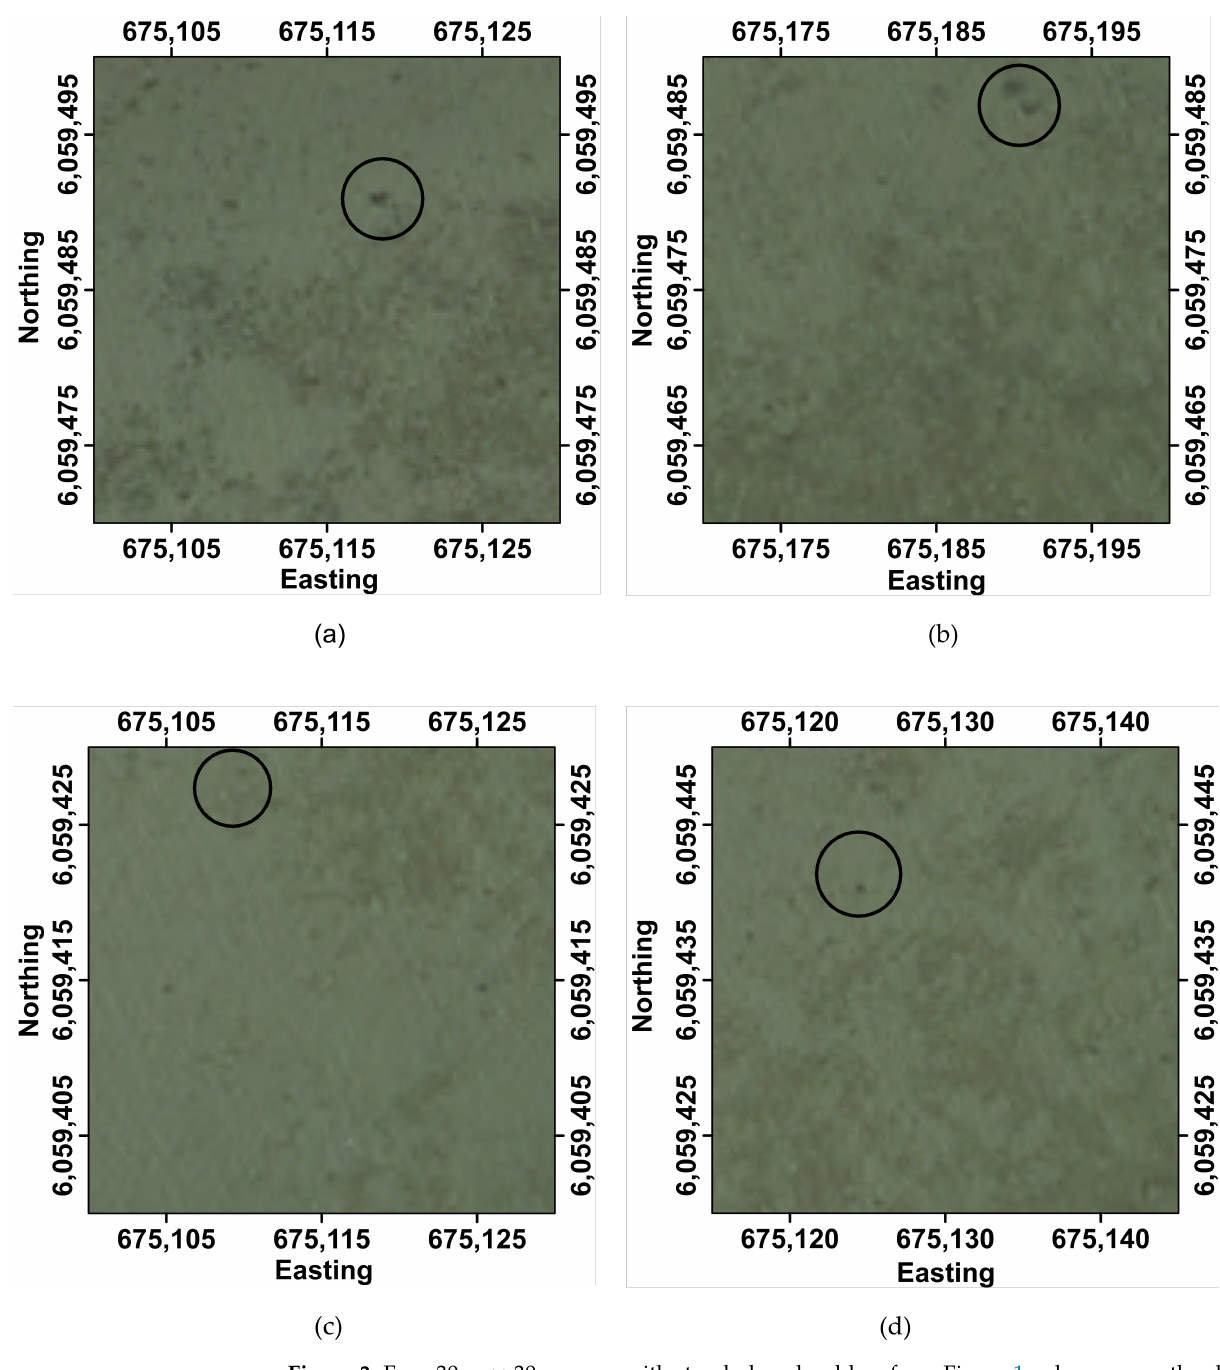
Figure 3. Four 30 m × 30 m areas with stand-alone boulders from Figure 1c, shown on orthophotos from 2015. ( a ) is in the upper left in Figure 1c (boulder 1 in black circle), ( b ) is to the right in Figure 1c (boulder 2 in black circle), ( c ) is in the bottom left in Figure 1c (boulder 3 in black circle), and ( d ) is in the middle left in Figure 1c (boulder 4 in black